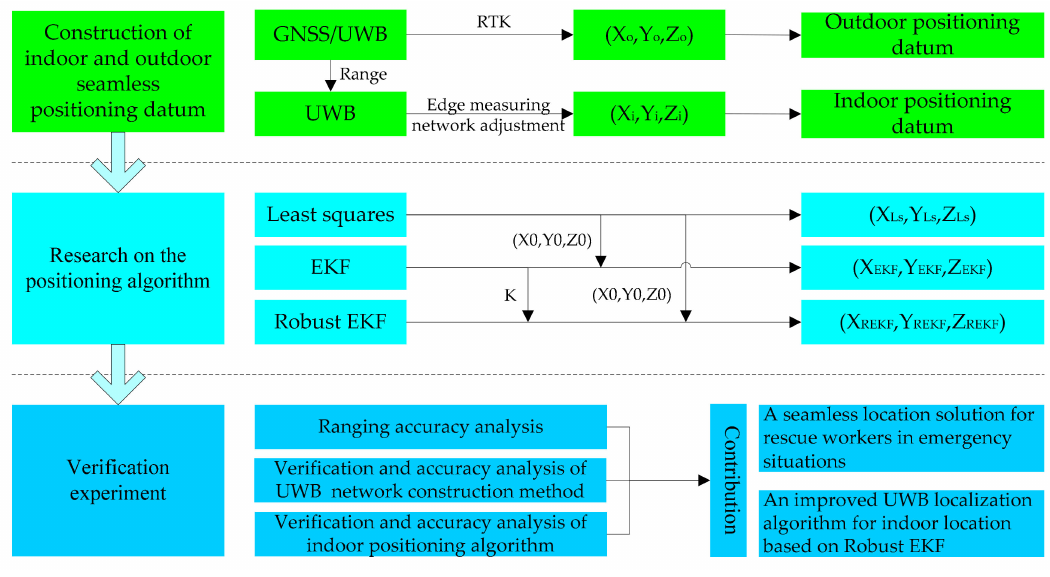
Figure 4. Technology